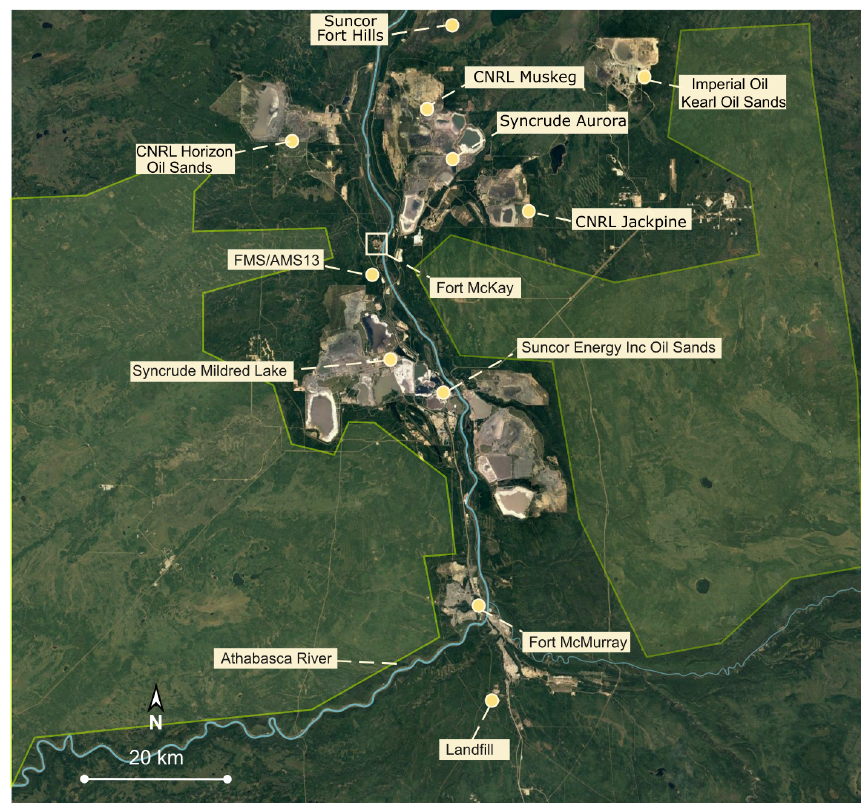
Figure 1. Satellite view of the Athabasca oil sands region (satellite image: Google Landsat/Copernicus) showing the location of oil sands mining and processing facilities and the FMS/AMS13 site from which samples described in this paper were collected (57 ◦ 08 (cid:48) 57.54 (cid:48)(cid:48) N, 111 ◦ 38 (cid:48) 32.66 (cid:48)(cid:48) W). The light green polygons show the approximate area of the forest–wetland complexes in the region (based on data from Golder Associates Ltd.,